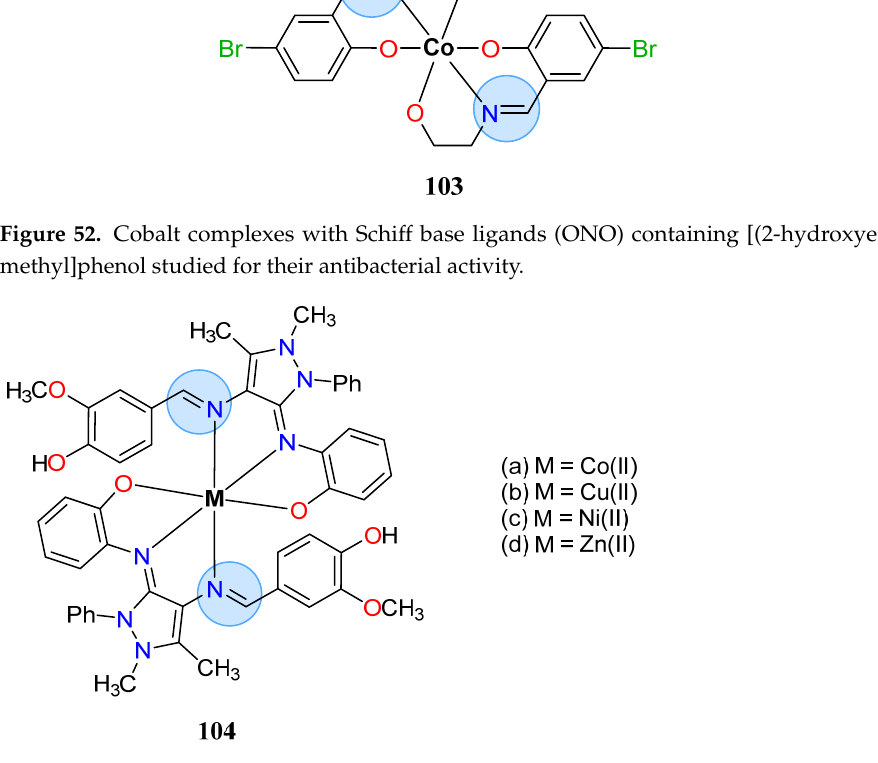
Figure 52. Cobalt complexes with Schiff base ligands (ONO) containing [(2 ‐ hydroxyethylimino)me ‐ thyl]phenol studied for their antibacterial activity.